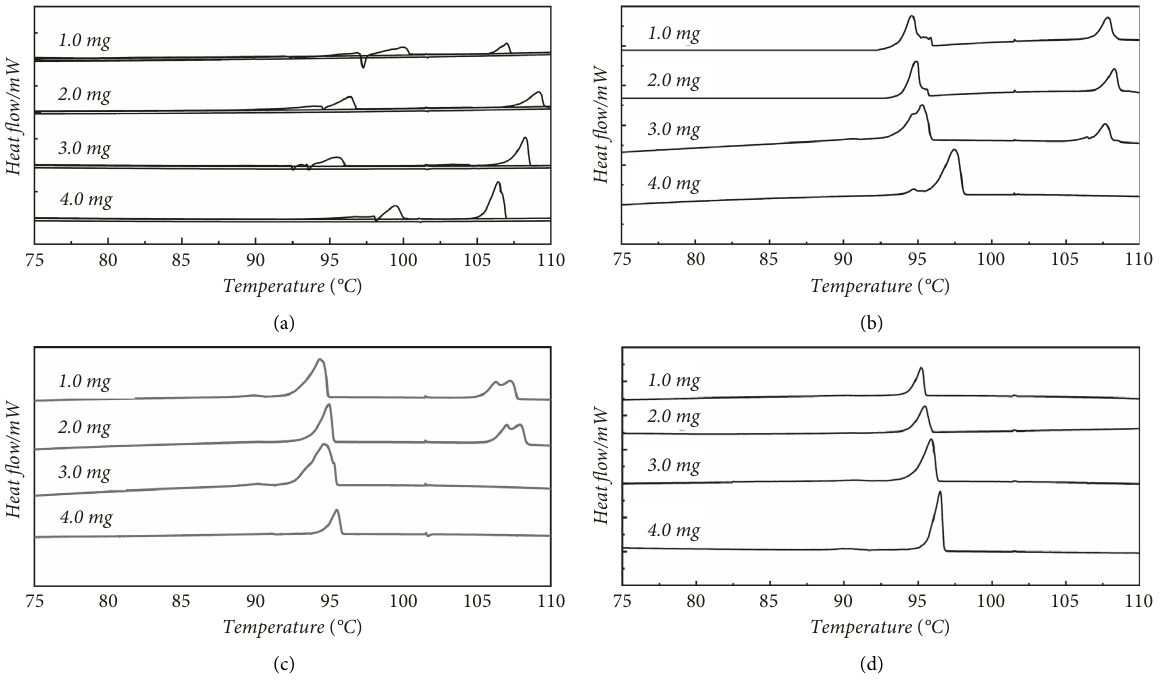
Figure 2: The DSC curves of four thermal history elimination methods. (a) The method of constant temperature near the melting point. (b) The method of repetitive heating. (c) The method of freeze-constant temperature heating. (d) The method of freeze-constant temperature